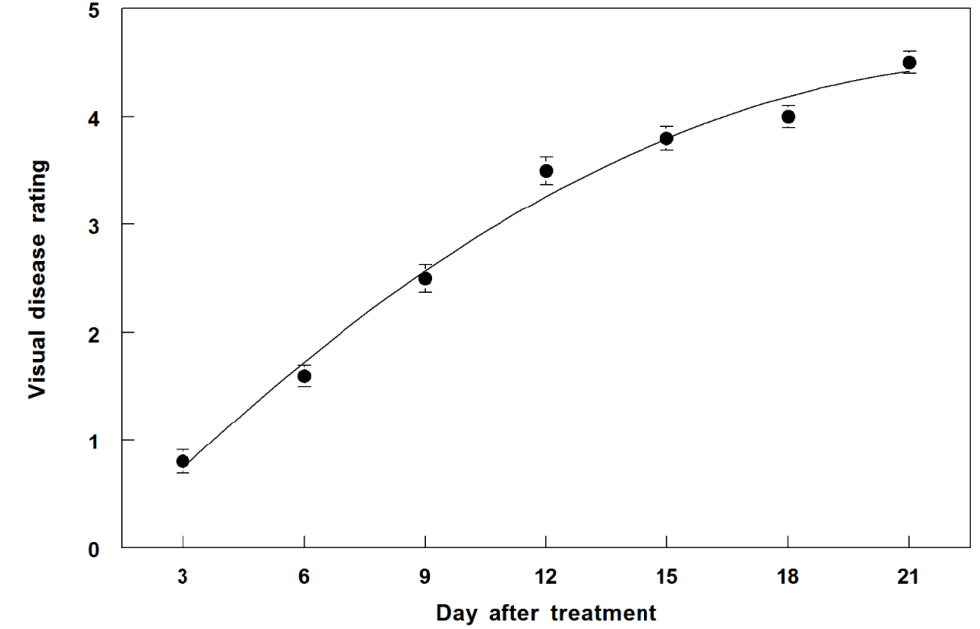
Figure 8. Disease progression of P. commelinicola on greenhouse-grown C. diffusa over a 21-day period after inoculation. The relationship for P. commelinicola disease progression is best described by the equation: Y = −0.15 + 0.37 X − 0.01 X 2 , R 2 = 0.98. Error bars represent Fisher’s LSD ( p =